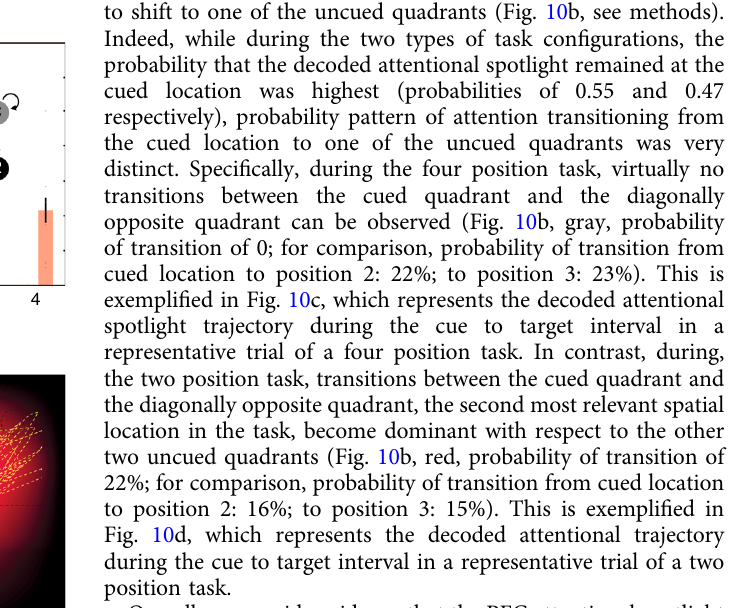
the four possible quadrants (18 sessions), and a second version in which the cue oriented attention to only two possible quadrants, placed along the diagonal one with respect to the other (16 sessions). For both monkeys, oscillations in the PFC attention information did not depend on the task (Fig. 10a). In contrast, how the decoded attentional spotlight was deployed onto space was drastically different between the two tasks. This is captured by the Markov chain probabilistic modeling of the probability of the spotlight to stay in the cued quadrant when already there, or